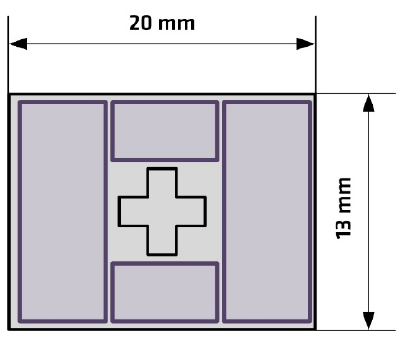
Figure 6. Schematic of the ROIs (purple color) for data capture.